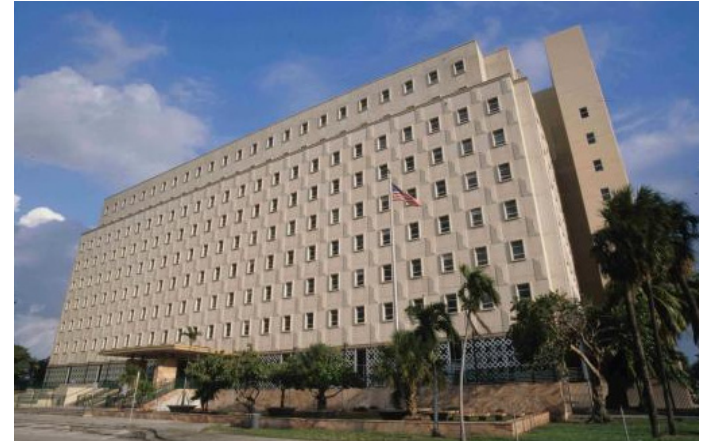
Figure 1. County courthouse building.